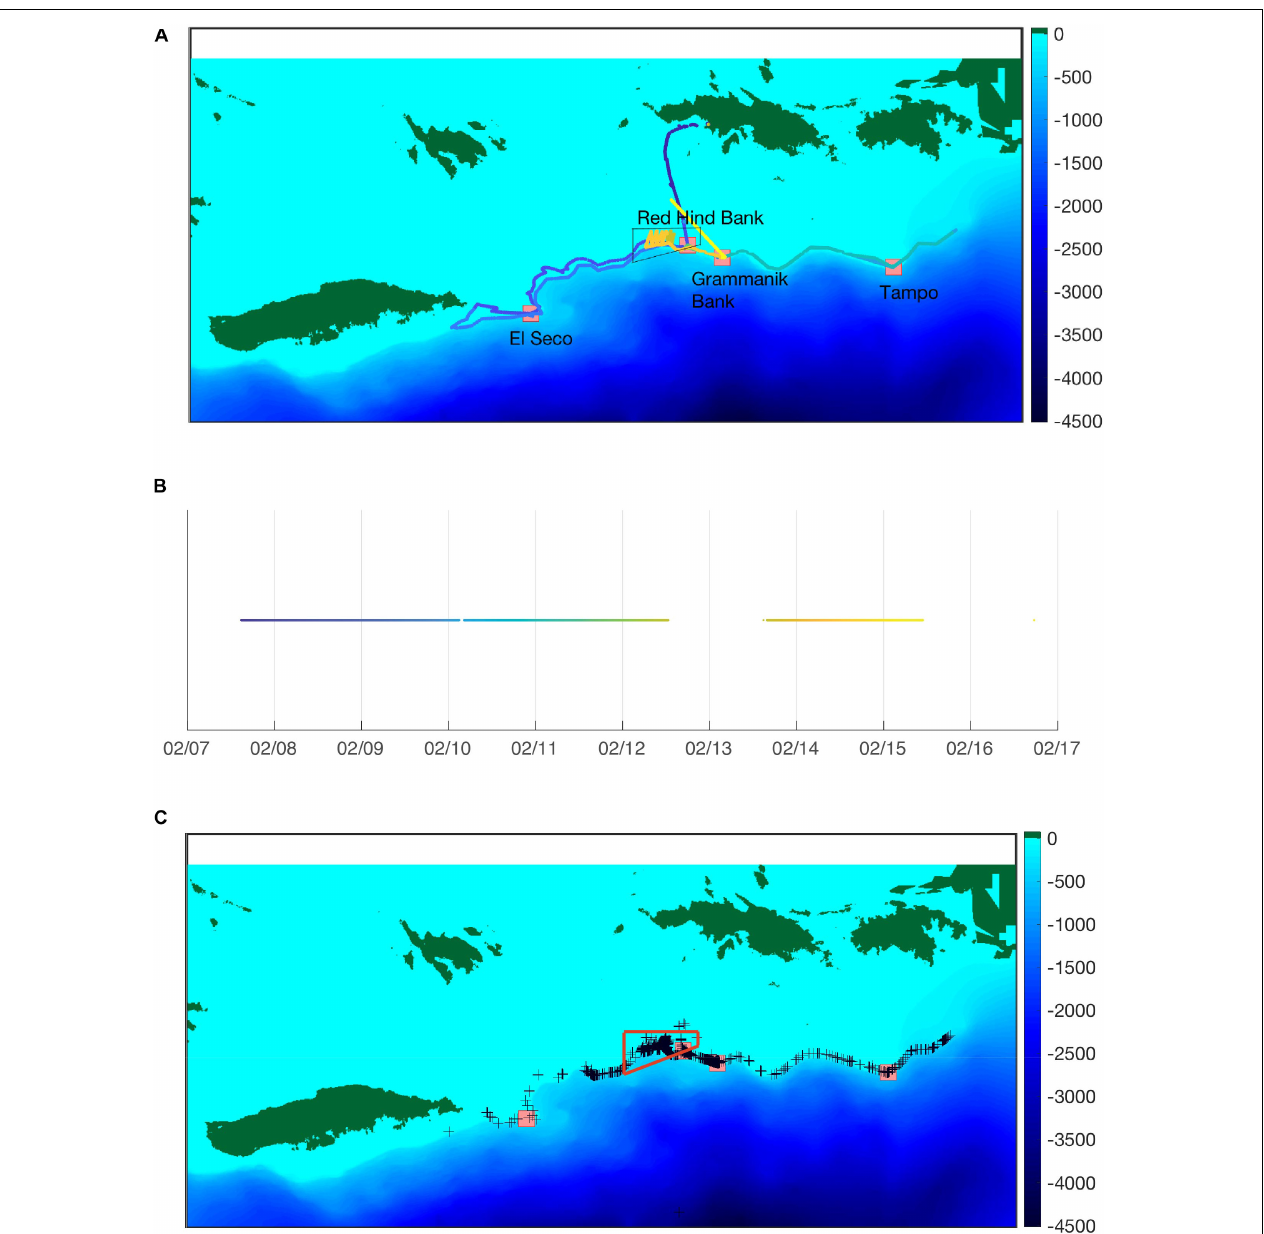
FIGURE 8 | (A) Global (top) and daily maps of the glider path along the southern U.S. Virgin Islands shelf edge from 7 to 15 February, 2017. Background colors indicate depths. Colors along the track indicate time shown in (B) . The wave glider track east of Tampo ends at the British Virgin Islands Border. The boundaries of the MCD are indicated by the black quadrilateral. (C) Red hind CAS indicated by black crosses as detected by the wave glider. The boundaries of the MCD are indicated by the red quadrilateral. Red squares also indicate known multi species fish spawning aggregations as labeled in (A) .